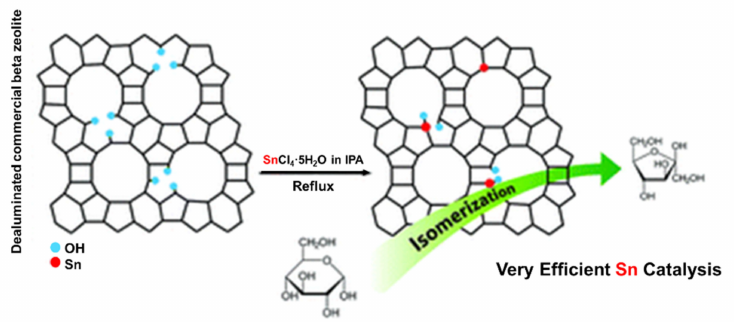
Figure 6. Schematic illustration for grafting Sn(IV) into deAl-Beta in isopropanol under reflux. Reproduced with permission from [30]. Copyright 2013, Royal Society of